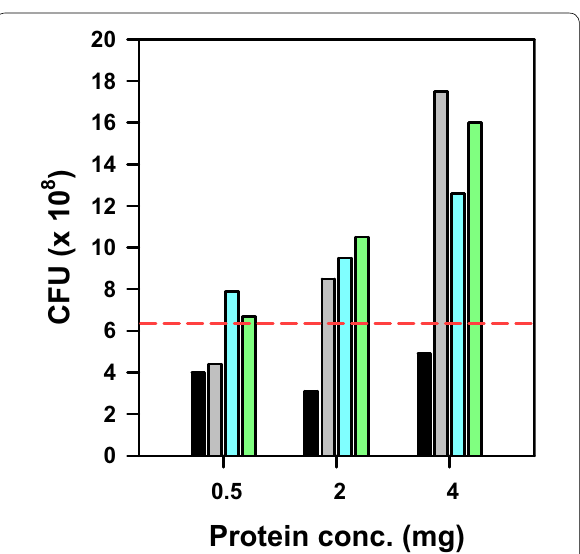
Fig. 5 Effect of protein amounts added from BL21(DE3) (white bar), DRP at 25 °C (black bar), and DRP at 30 °C (grey bar) on the prebiotic activity of L. rhamnosus